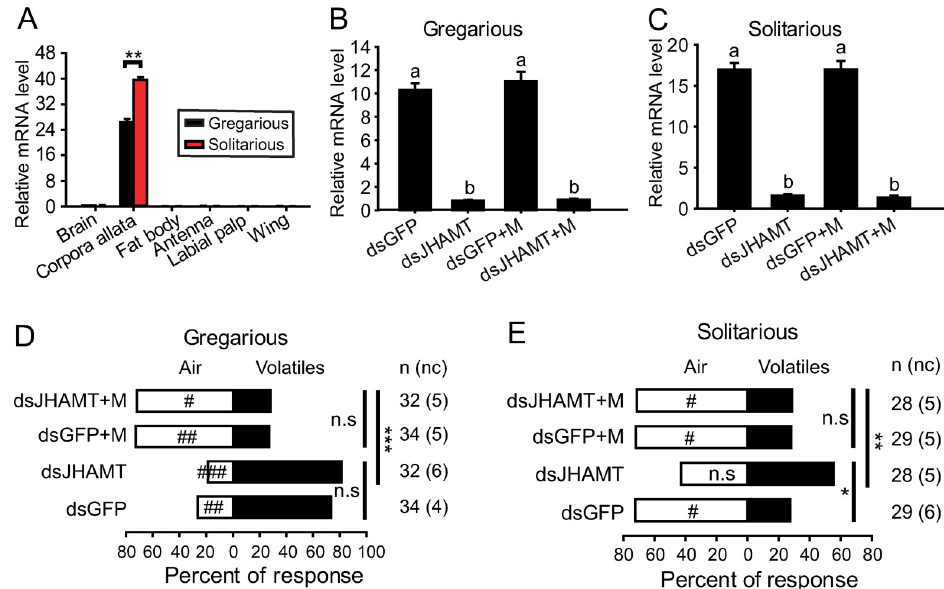
Fig 2. Effect of JHAMT knockdown on choice behavior in the fourth-instar nymphs. (A) Relative mRNA level of JHAMT in six selected tissues of gregarious and solitarious nymphs, respectively. (B) Relative mRNA level of JHAMT after injection of dsGFP or ds JHAMT or rescued by methoprene in gregarious nymphs. (C) Relative mRNA level of JHAMT after injection of ds GFP or ds JHAMT or rescued by methoprene in solitarious nymphs. (D) Choice behavior of gregarious nymphs at Day 3 after injection of ds GFP or ds JHAMT or rescued by methoprene in gregarious nymphs. (E) Choice behavior of gregarious nymphs at Day 3 after injection of ds GFP or ds JHAMT or rescued by methoprene in solitarious nymphs.